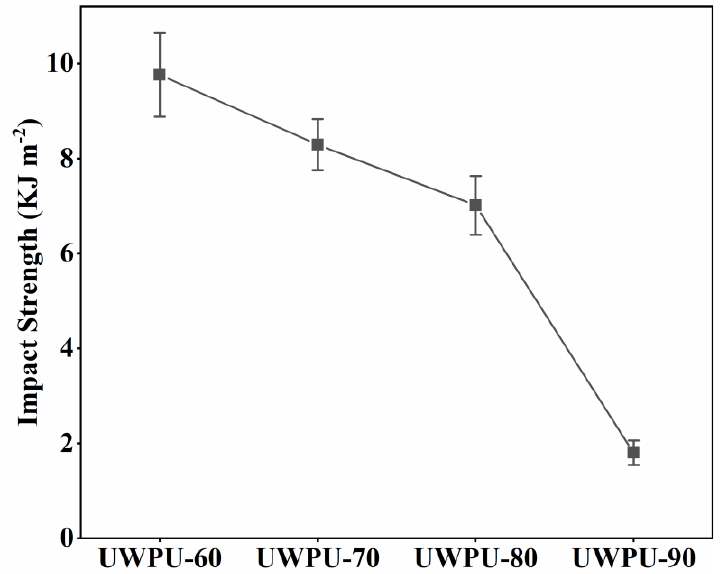
Figure 4. Mechanical properties of UWPU composites: ( a ) tensile stress – strain curves; ( b ) Young’s modulus; ( c ) three-point flexural stress – strain curves; ( d ) flexural modulus.